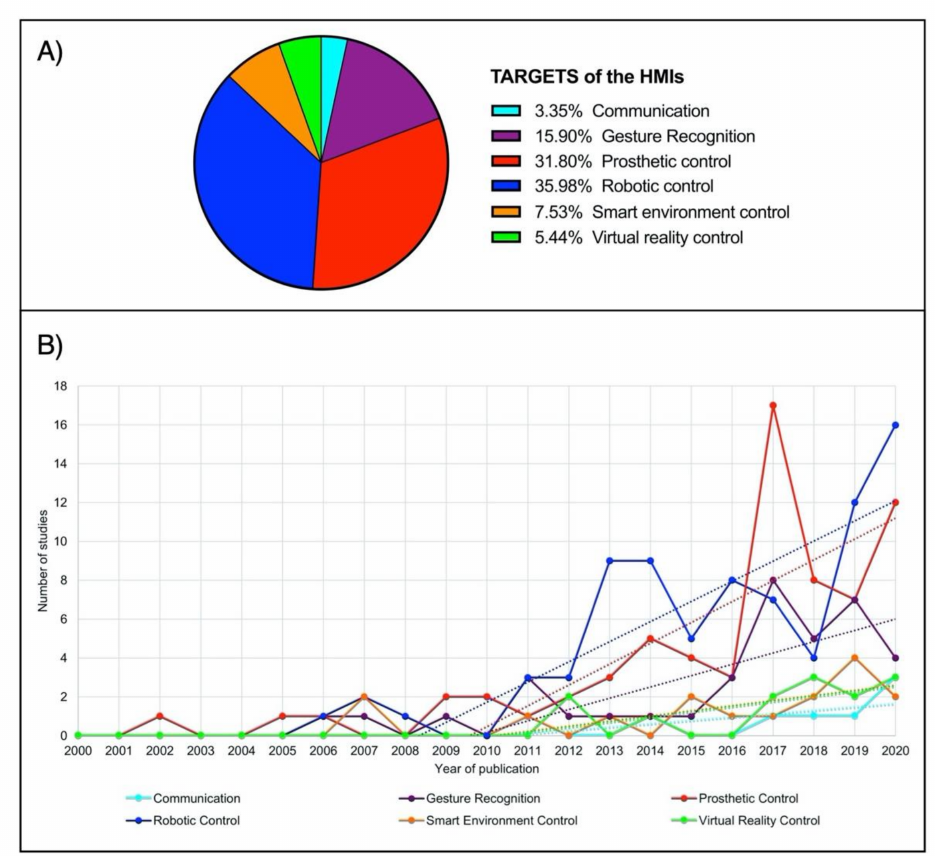
Figure 4. ( A ) Pie diagram illustrating the percentage distribution of the considered targets by the selected HMIs. ( B ) Graph illustrating the trend in the last two decades of each target (depicted in a different colour) of the considered HMIs with assistive and/or rehabilitative applications. Linear regressions (starting from 2010) are also superimposed as dashed lines.